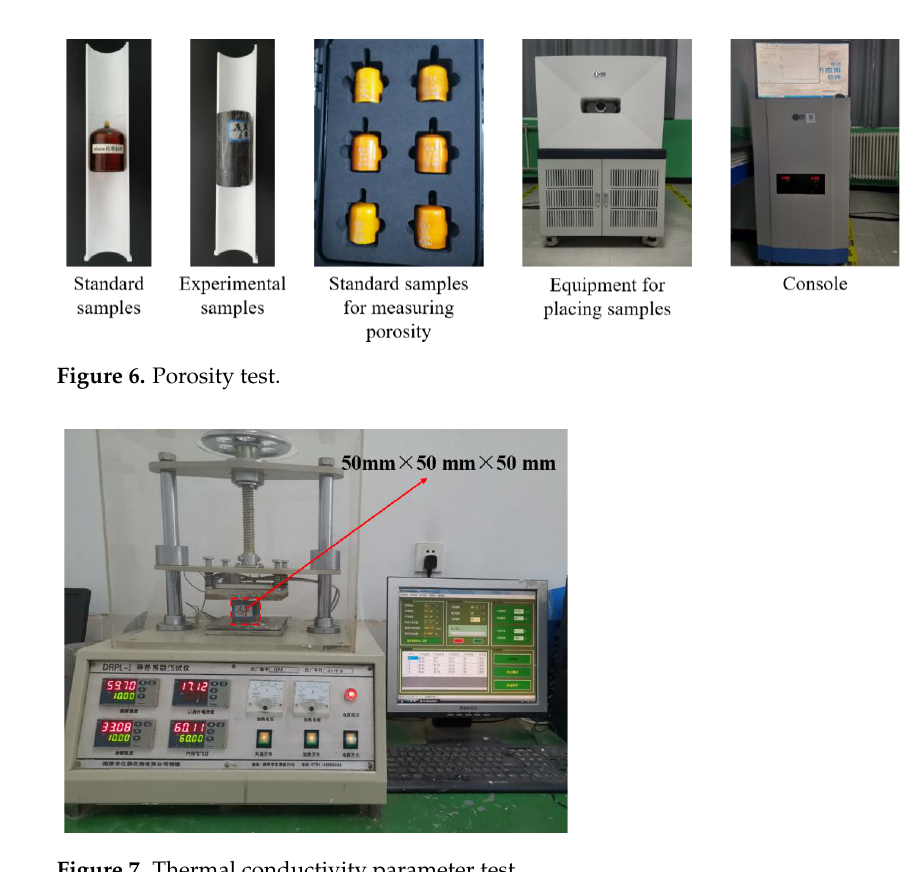
Figure 5. Specimen density and water content test.